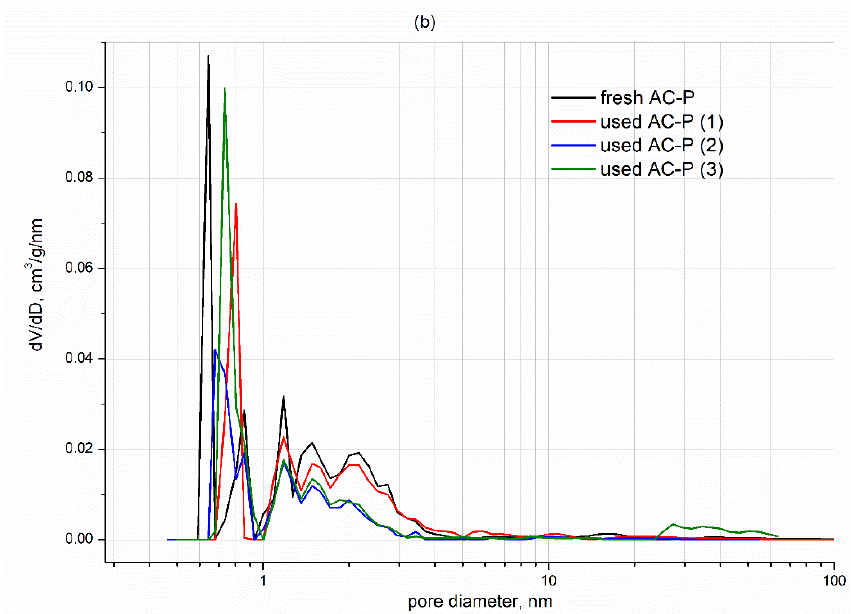
Figure 4. Nitrogen adsorption–desorption isotherms ( a ) and pore-size distributions ( b ) for activated carbon samples: fresh AC-P, used AC-P (1), used AC-P (2), and used AC-P (3).